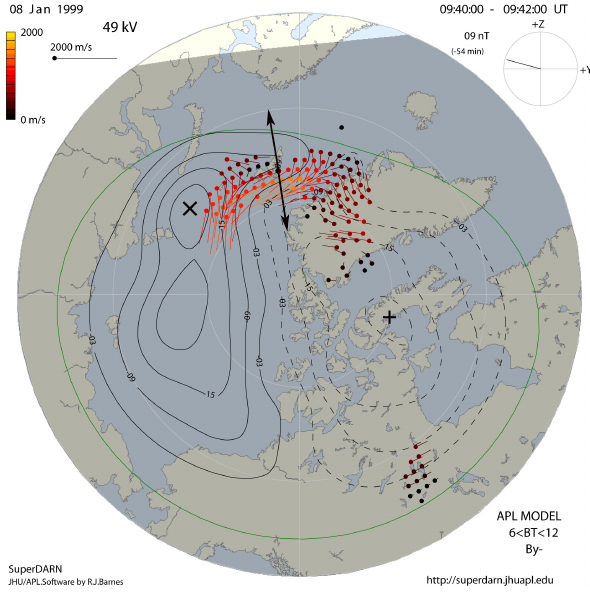
Fig. 20. SuperDARN convection data for 09:30–09:32UT. Same format as in Fig. 8.